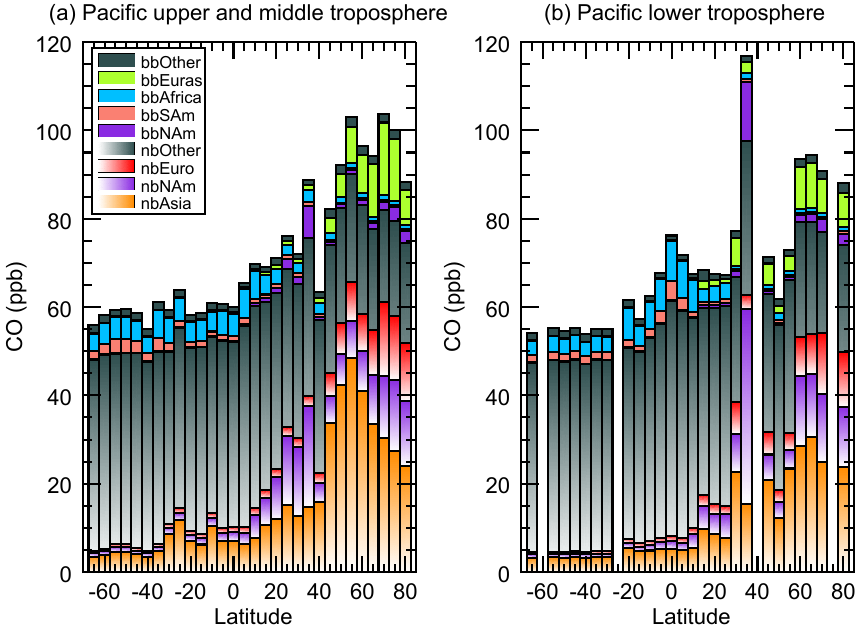
Figure 5. The contribution of each tagged CO tracer over the Pacific in the (a) upper and middle troposphere (pressure < = 850hPa) and (b) lower troposphere (pressure > 850hPa). Data from multiple flights over the region between 120 ◦ E and 110 ◦ W are included, with each bar representing data averaged over a 5 ◦ latitude bin. Shaded bars represent non-BB CO from Asia (orange), N. America (purple), Europe (red), and the rest of the world (gray). Solid bars represent BB CO from N. America (purple), S. America (pink), Africa (cyan), Eurasia (green), and the rest of the world (gray).